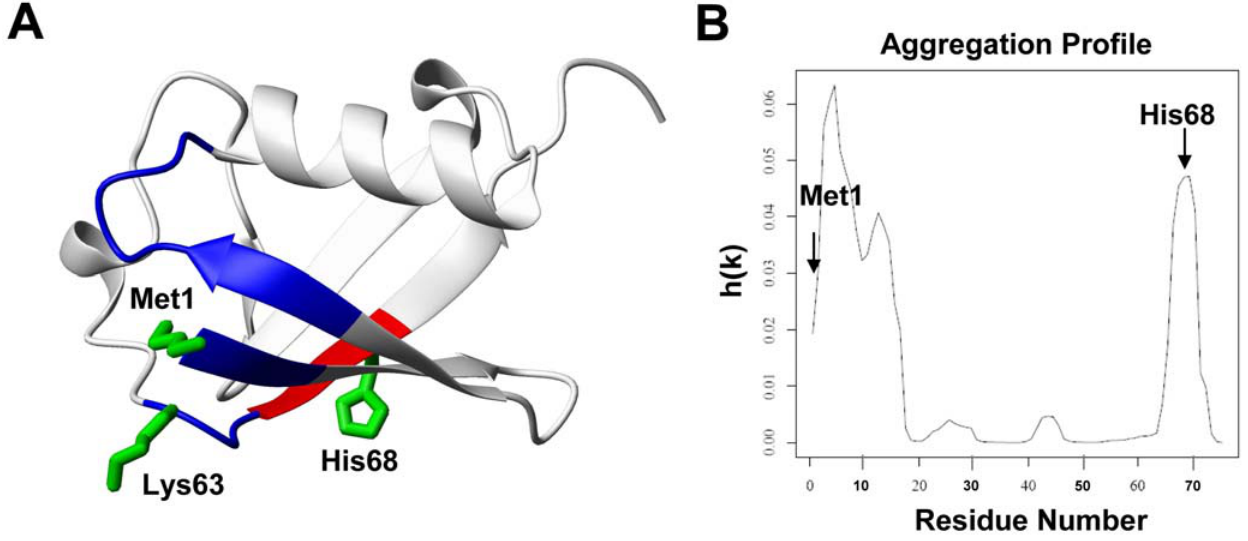
Figure 1. Cu II ions target the aggregation-prone regions of Ub. A) Mapping the effects of paramagnetic Cu II binding on the Ub NMR signals (PDB ID 1UBQ): Ub residues whose signals are broadened beyond detection are colored in blue for the primary site (Met1) and in red for the secondary site (His68); Lys63 is also shown; B) Aggregation profile of Ub obtained with the program PASTA.